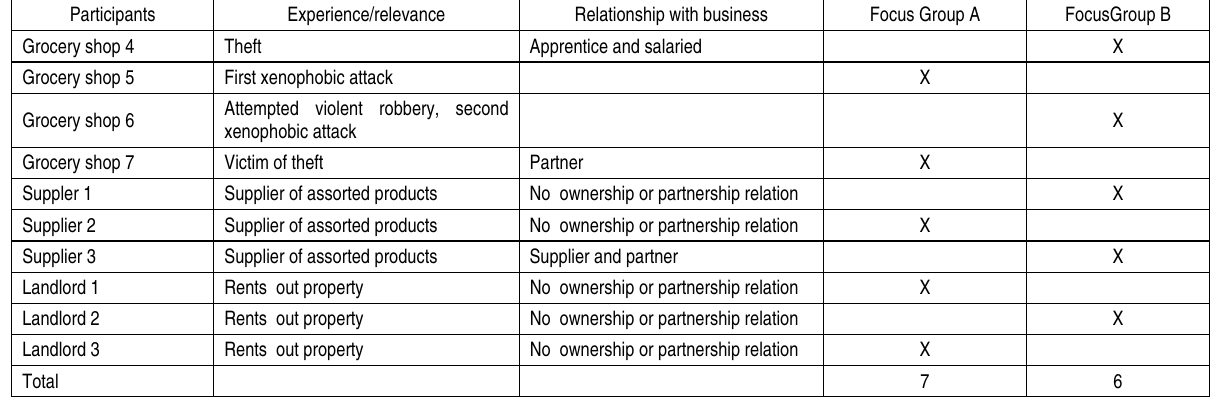
Table 1 (cont.). Background data of the grocery shop operators